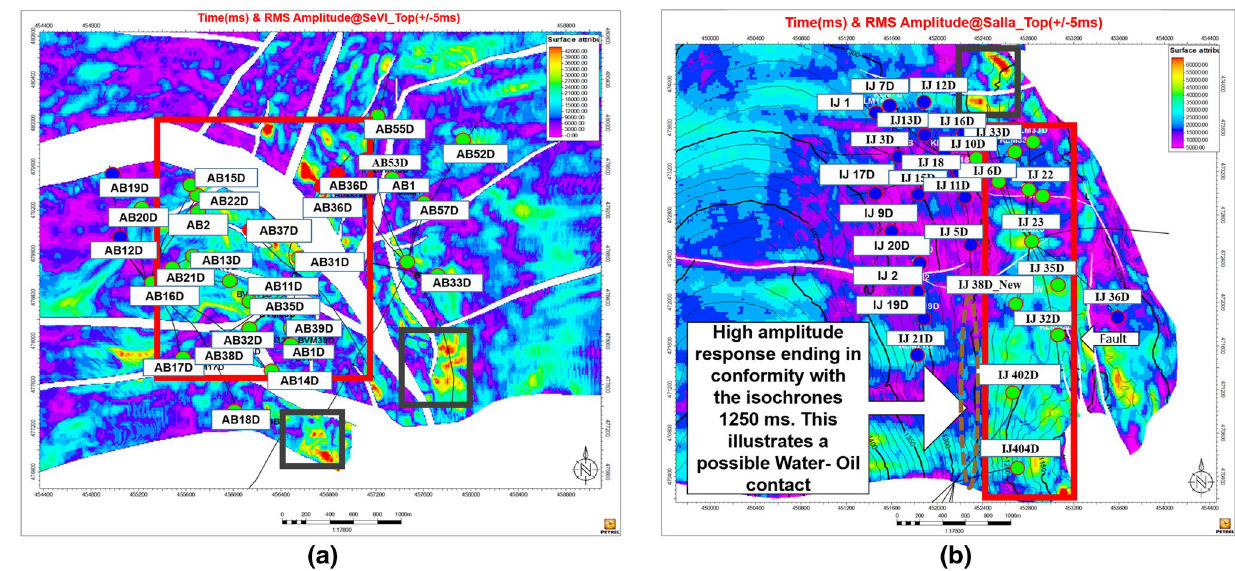
Fig. 7 Reservoir RMS amplitude map a AB SeVI; b IJ SaIIa